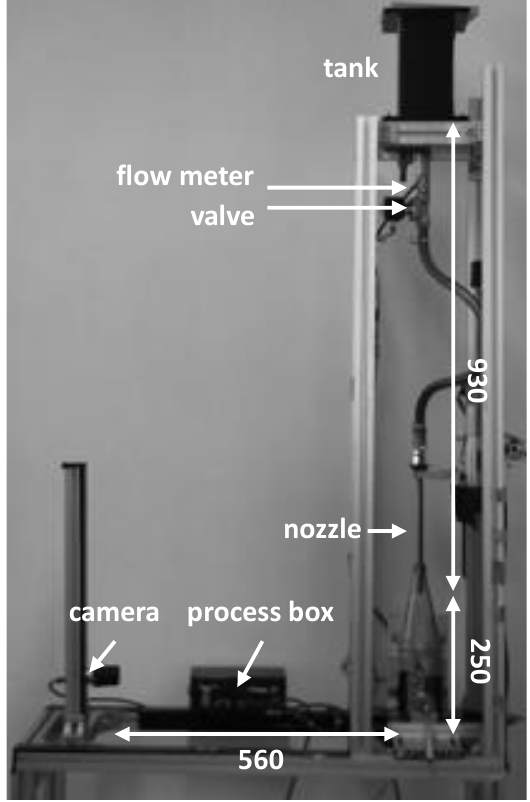
Figure 1. filling setup (here: without heating bath) with given distances [mm]. Figure 1. Filling setup (here: without heating bath) with given distances [mm].